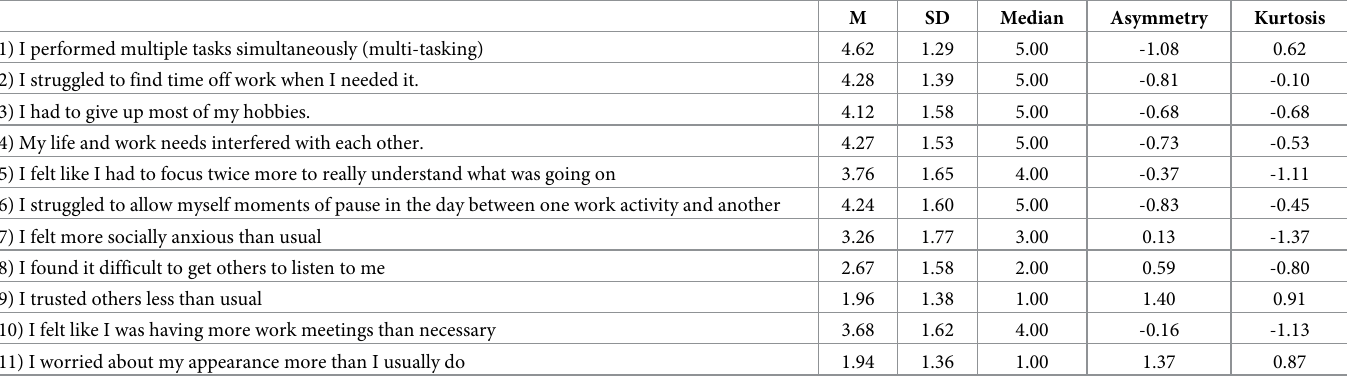
Table 2. Descriptive statistics for Online Fatigue Scale items on total sample (N = 307).